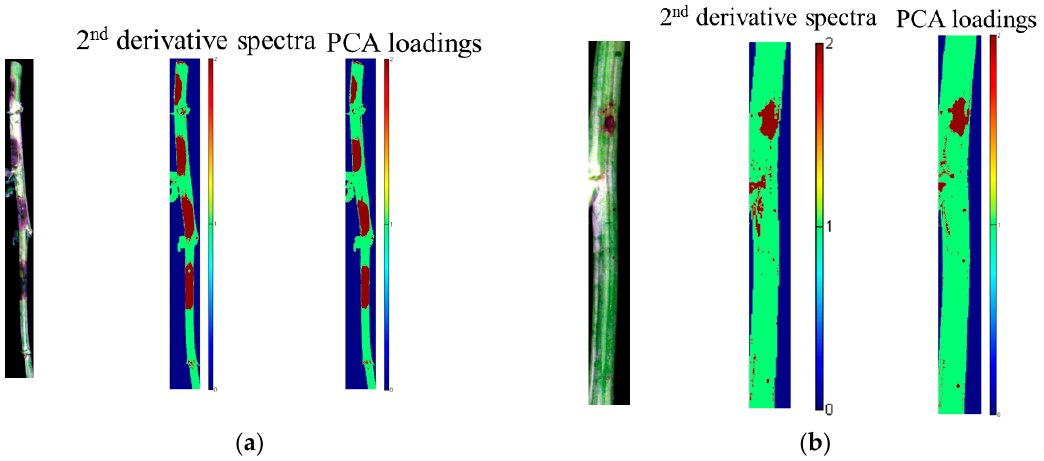
Figure 5. Image visualization of one randomly selected sample from each sample set by the SVM models using optimal wavelengths ( a ) sample set 1, ( b ) sample set 2.